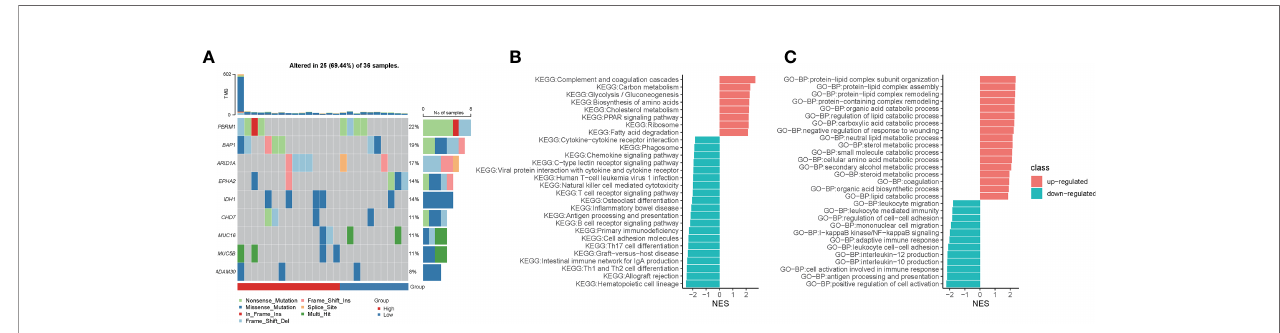
FIGURE 5 | Hypoxia-related risk scores reveal differences in tumor immune microenvironment characteristics. (A) The heatmap for mutational gene and mutation type in the high- and low-risk groups. (B) The GSEA enrichment analysis for KEGG signaling pathways between the high- and low-risk groups. (C) The GSEA enrichment analysis for biological processes from the GO database between the high- and low-risk groups.